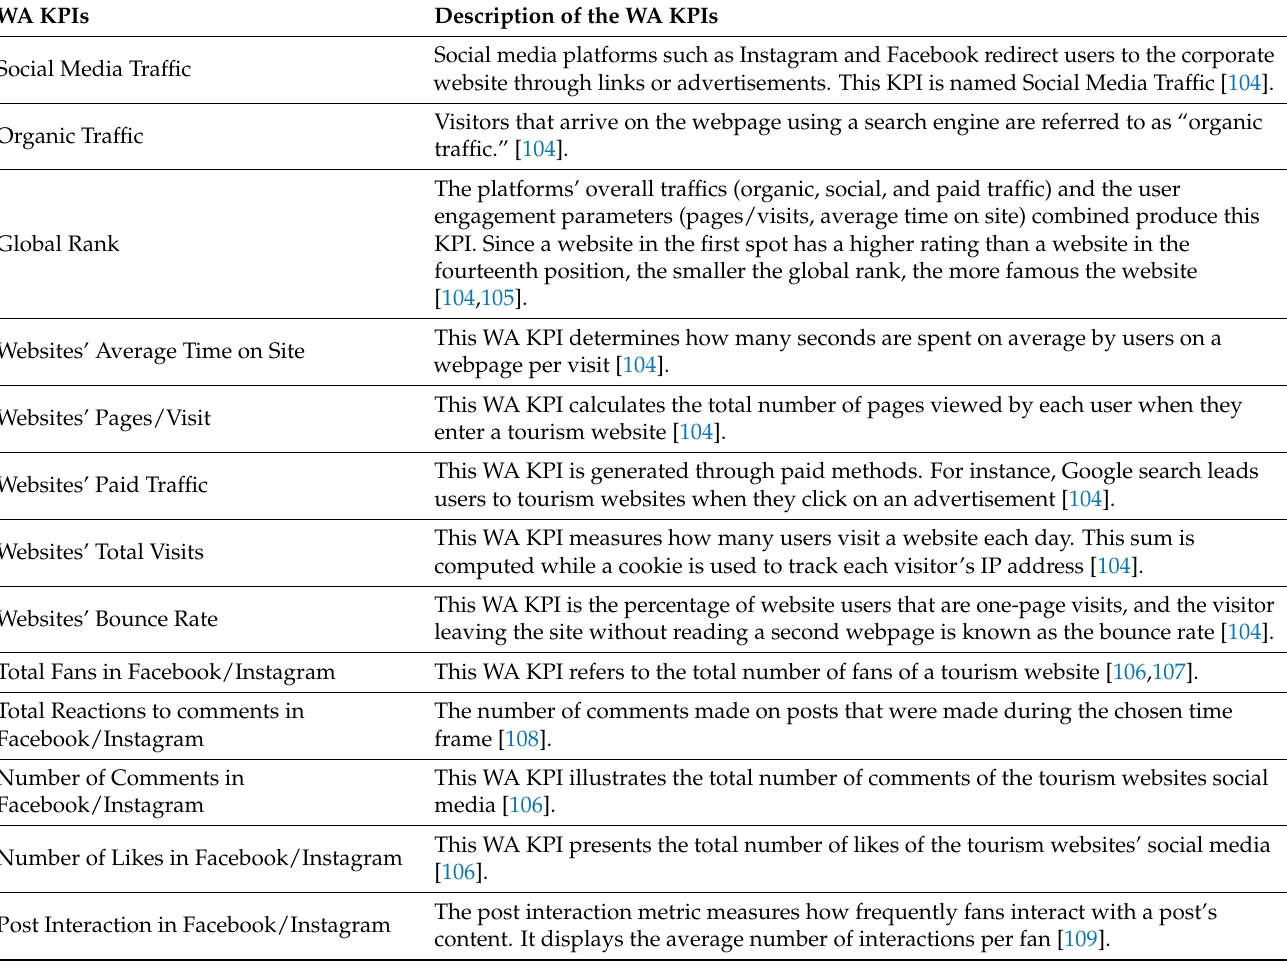
Table 1. Description of the Web analytics KPIs. WA KPIs Description of the WA